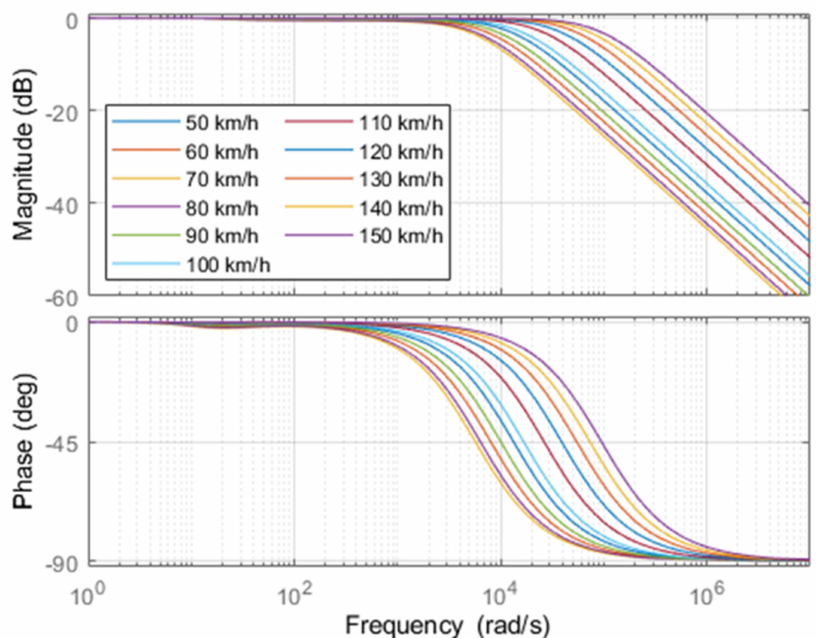
Figure 10. Bode diagrams for a classic PID controller.